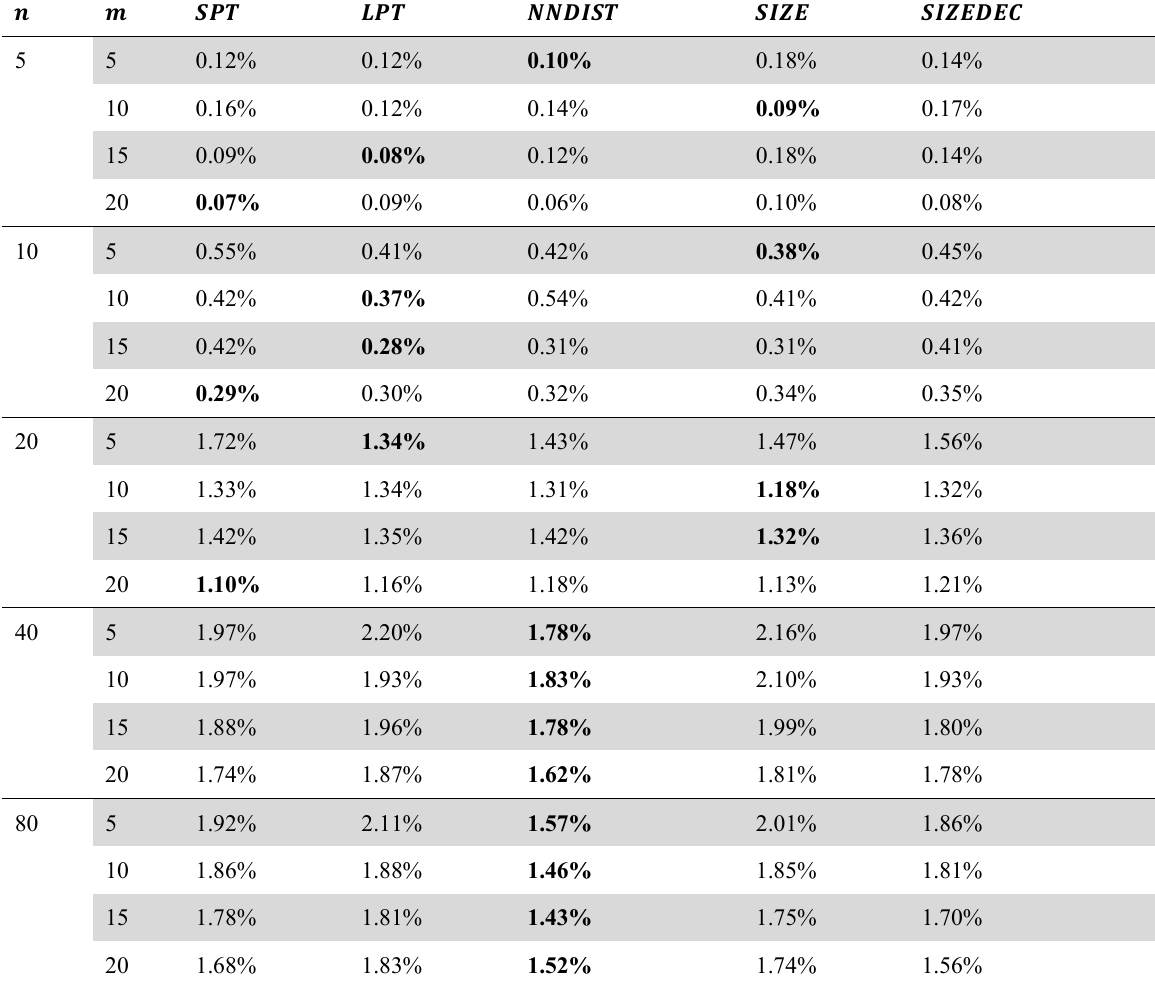
ARD of 𝐼𝐺 for each initial sequence, when compared to the minimum value found. Results sorted by 𝑛 and 𝑚 (cid:3021)(cid:3021)(cid:3015)